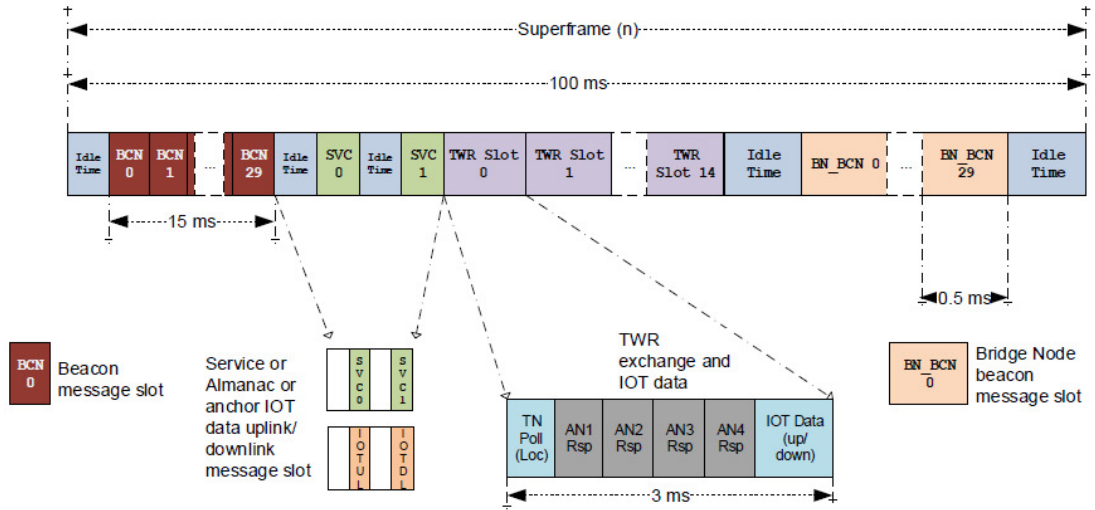
Figure 3. Superframe of Decawave’s PANS protocol for its DWM1001 modules. The protocol limits to four anchors the maximum number of ranges that each tag can measure within its TWR slot. However, it is quite scalable in the number of tags which can be operative at the same time—for example, 15 tags every 100 ms, or 150 tags at 1 Hz